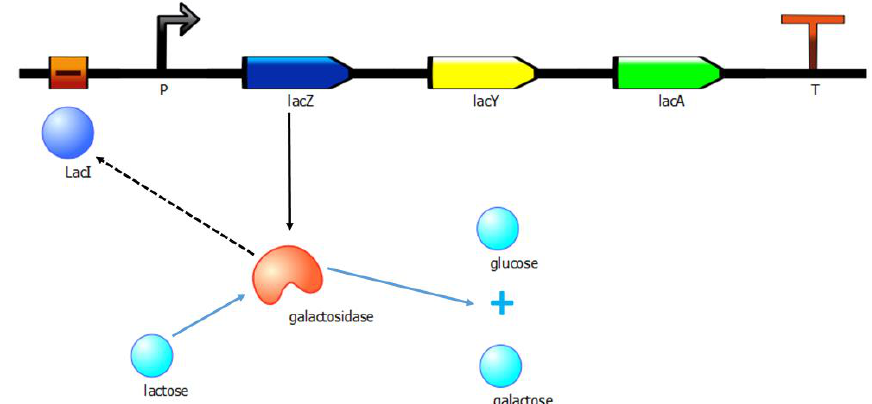
Figure 5. In simulation experiments, when a bacterium satisfies a given condition, then the bacterium elementary model of the Lac operon: The lacZ gene synthesizes an enzyme named galactosidase, i.e.,